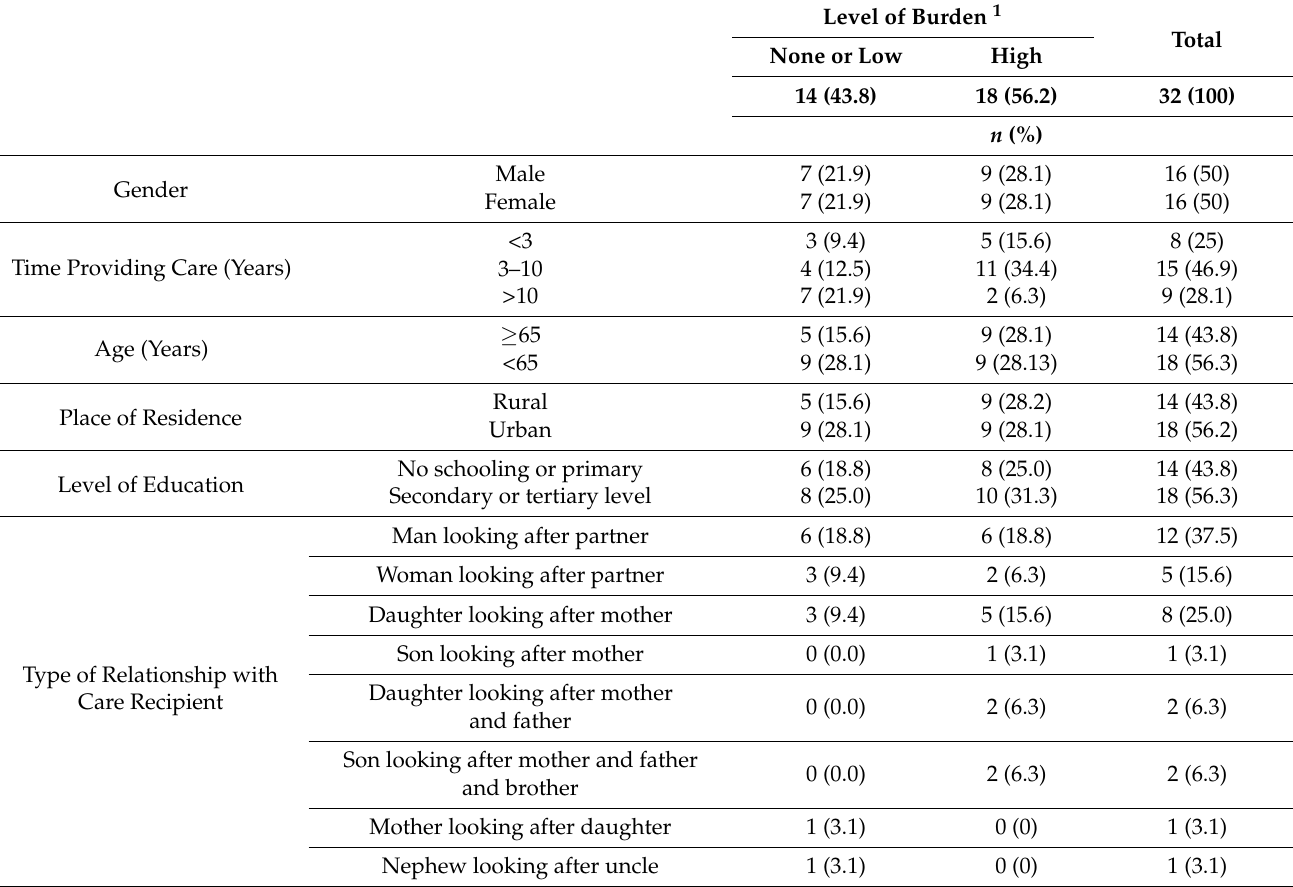
Table 1. Sociodemographic and caregiving characteristics of